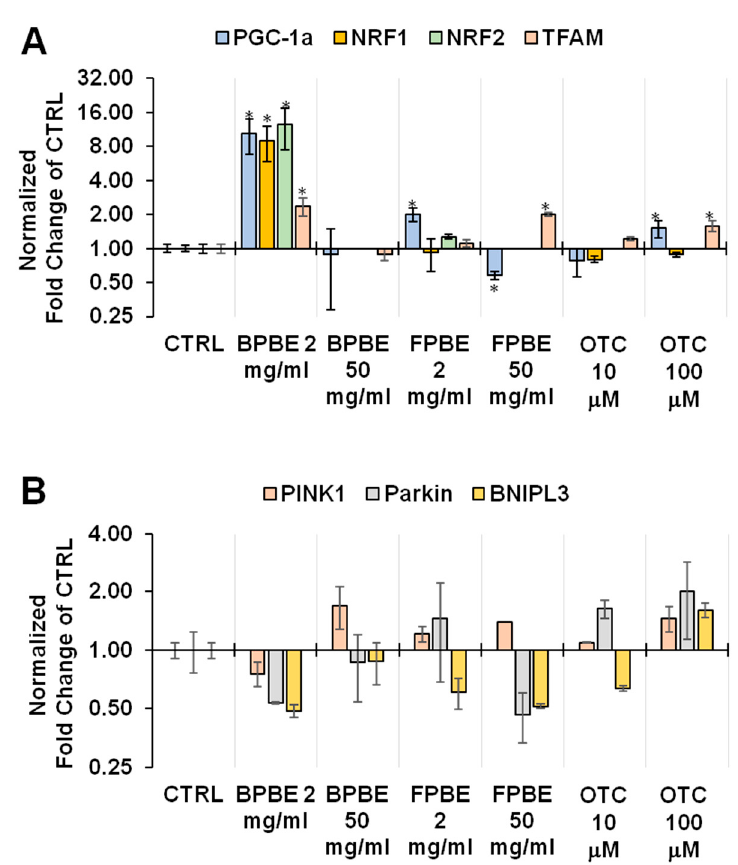
Figure 6. Effect of chicken bone powder treatment on the transcription of selected genes involved in mitochondriogenesis and mitophagy in K562 cells. Cells were treated with either BPBE, FBPE, or OTC at the indicated concentrations and subjected to quantitative RT-PCR on extracted RNA as detailed in Materials and Methods. The expression of the indicated selected genes involved in the mitochondrial biogenesis ( A ) or mitophagic processing ( B ) is shown as fold changes of the untreated (CTRL) cells (in a log scale); bars are means ± SEM of three independent experiments with three technical replicates under each condition; * p < 0.05 as compared with CTRL.